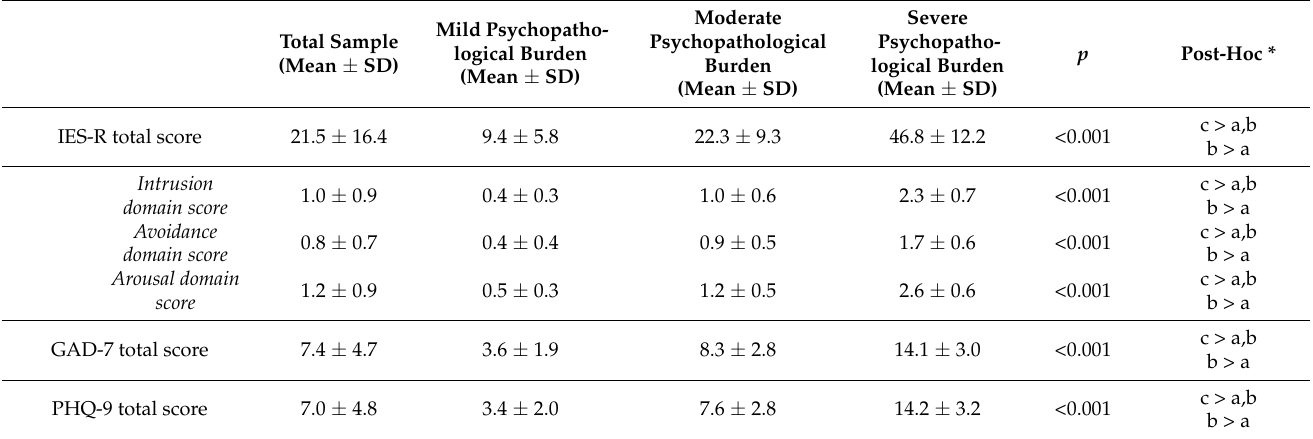
Table 3. Comparison of IES-R, GAD-7 and PHQ-9 scores in the total sample ( n = 139) and in the Mild psychopathological burden ( n = 62), Moderate psychopathological burden ( n = 49) and Severe psychopathological burden ( n = 28) groups.